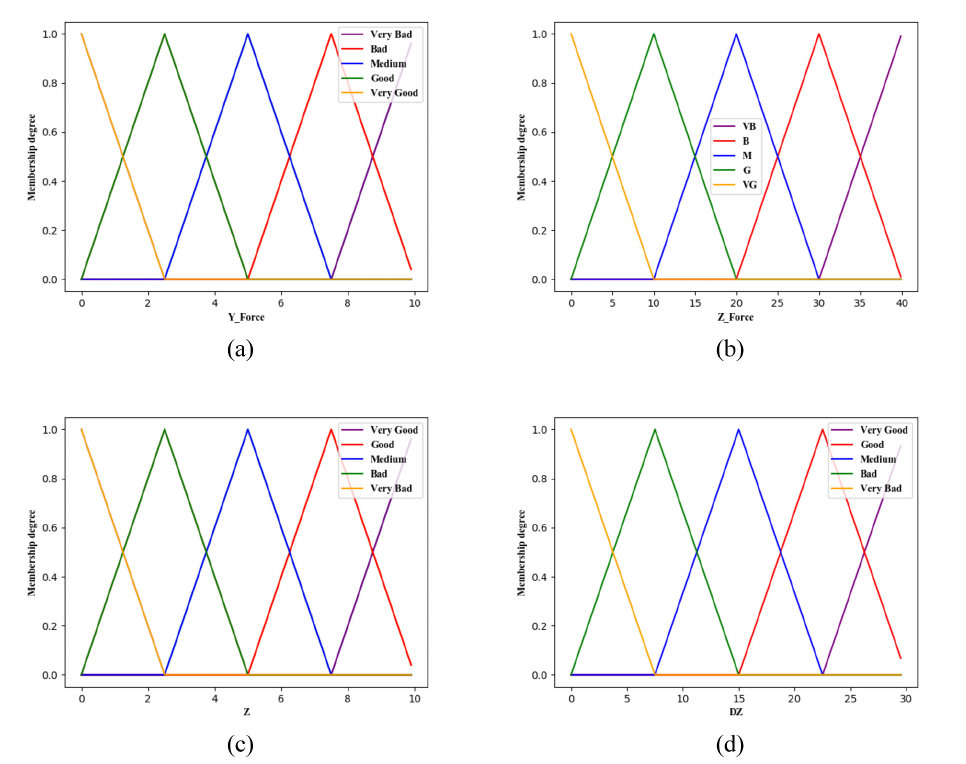
Figure 6. The first layer of membership function: ( a ) F y membership function; ( b ) F z membership function; ( c ) Z membership function; ( d ) D Z membership function.